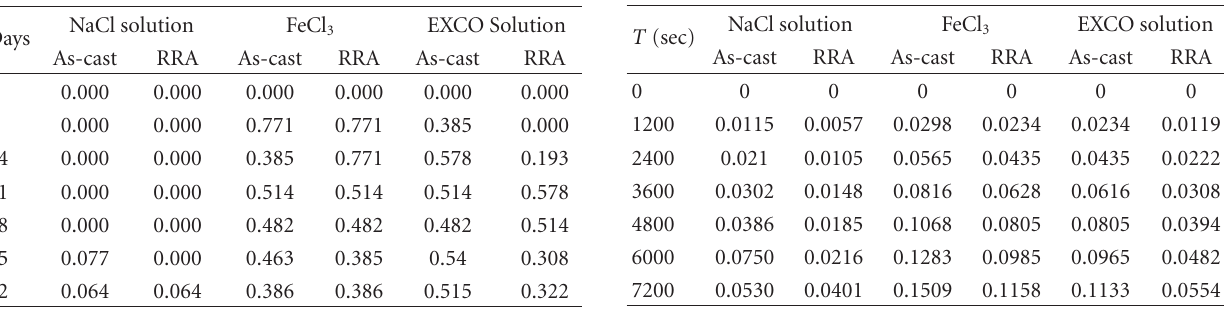
Table 11: Electrochemical corrosion rate for the 1.23% Mg specimen.